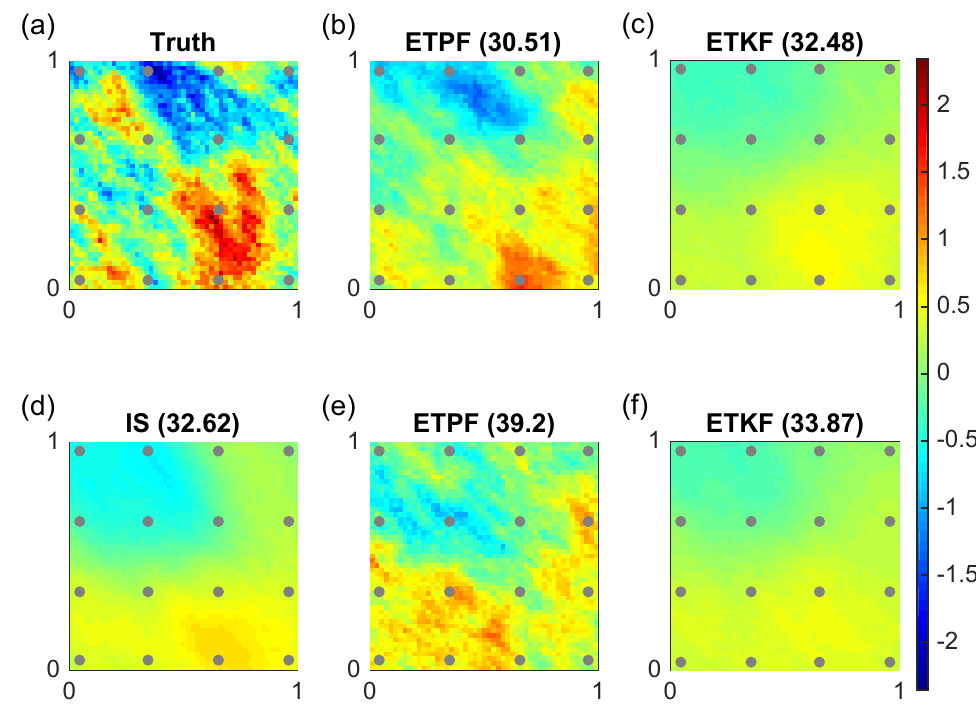
Figure 8. Log permeability field with dots representing the observation locations. Truth is shown in (a) and mean obtained by IS with ensemble size 10 5 in (d) . Mean obtained with ensemble size 10 3 by ETPF shown in (b)–(e) and by ETKF in (c)–(f) , where (b)–(c) are at the smallest RMSE and (e)–(f) are at the largest RMSE over simulations. The corresponding RMSE is given in parentheses.